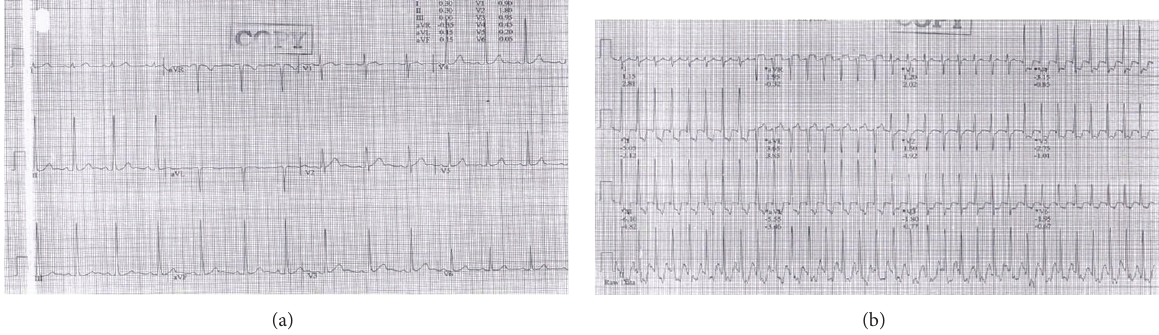
Figure 1: Electrocardiogram of the case before treadmill test (a) and during treadmill test showing ischemic sign (b).